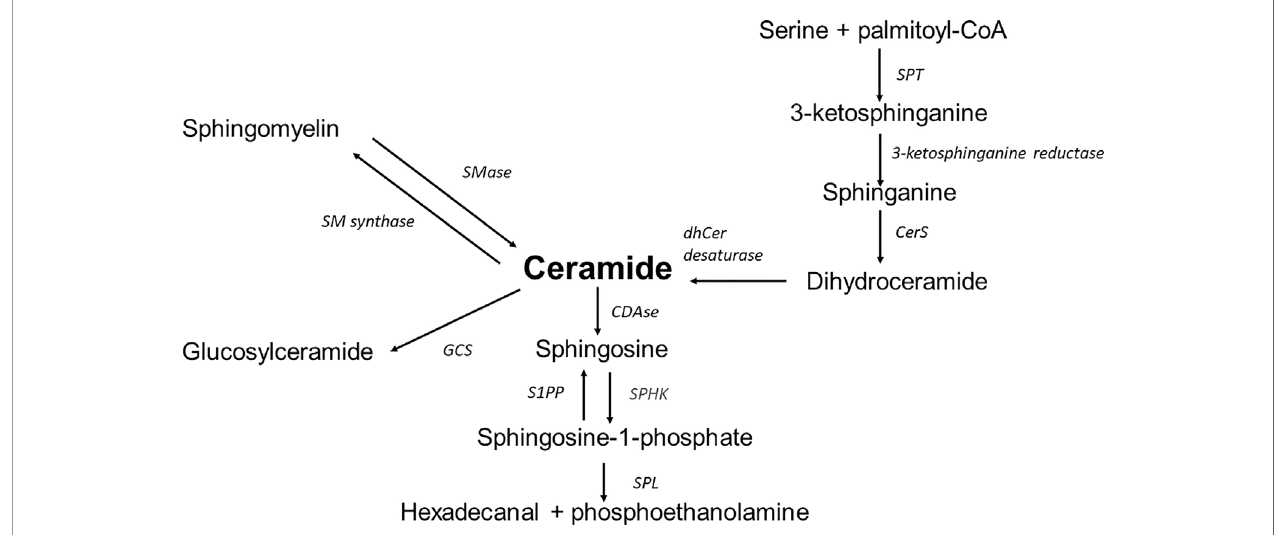
FIGURE 1 | Overview of sphingolipid metabolism; SPT, serine palmitoyltransferase; CerS, ceramide synthase; dhCer desaturase, dihydroceramide desaturase; S1PP, sphingosine-1-phosphate phosphatase; SPHK, sphingosine kinase; SPL, sphingosine-1-phosphate lyase; CDase, ceramidase; SMase, sphingomyelinase; SM synthase, sphingomyelinase synthase; GCS, glucosyl-ceramide